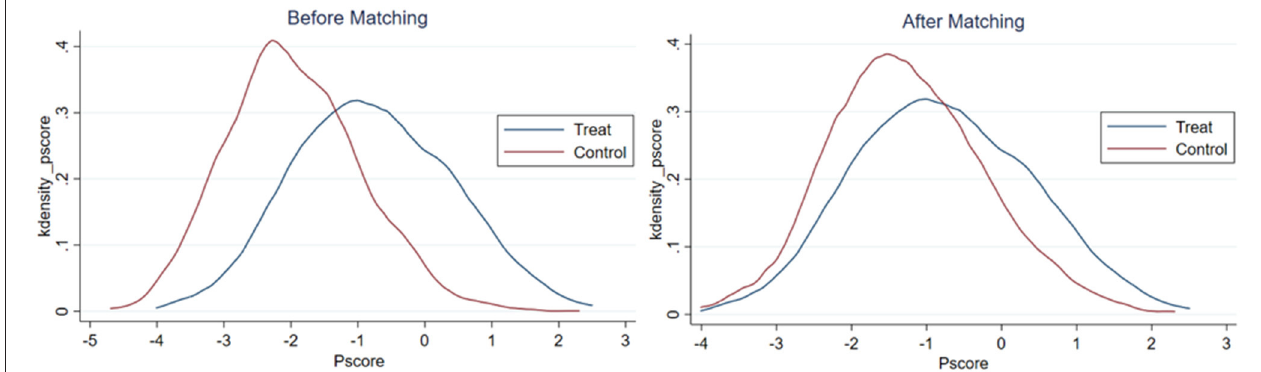
Frontiers in Public Health |